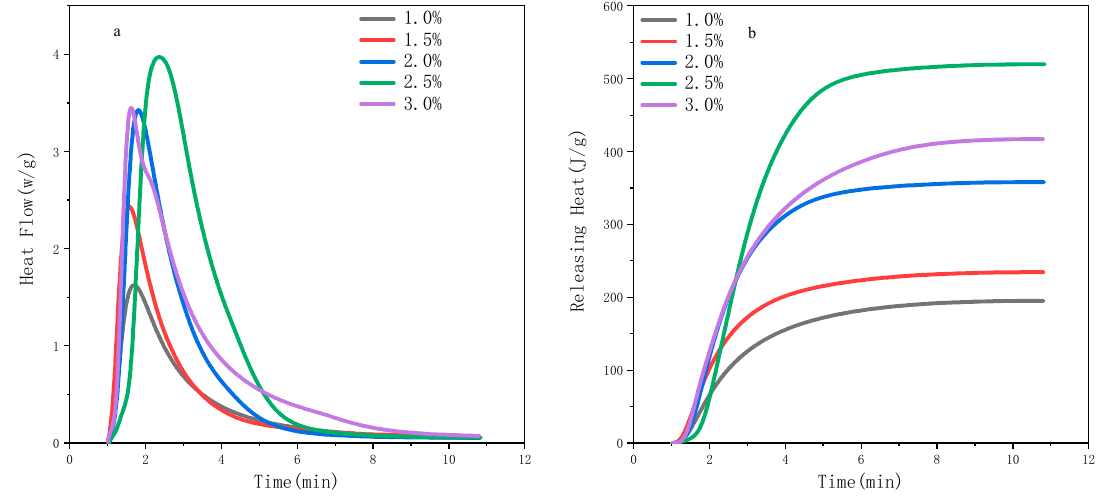
Figure 10. Effect of A-TiO 2 content on photo-polymerisation performance of PU-TiO 2 ink: ( a ) photo-polymerisation rates, ( b ) heat releasing.